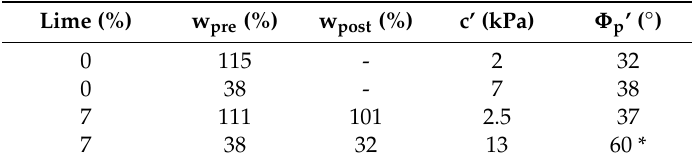
Table 3. Shear strength parameters of the treated and untreated soil compacted at different water contents (*values to be intended as model shear resistance angles, as discussed in the text).